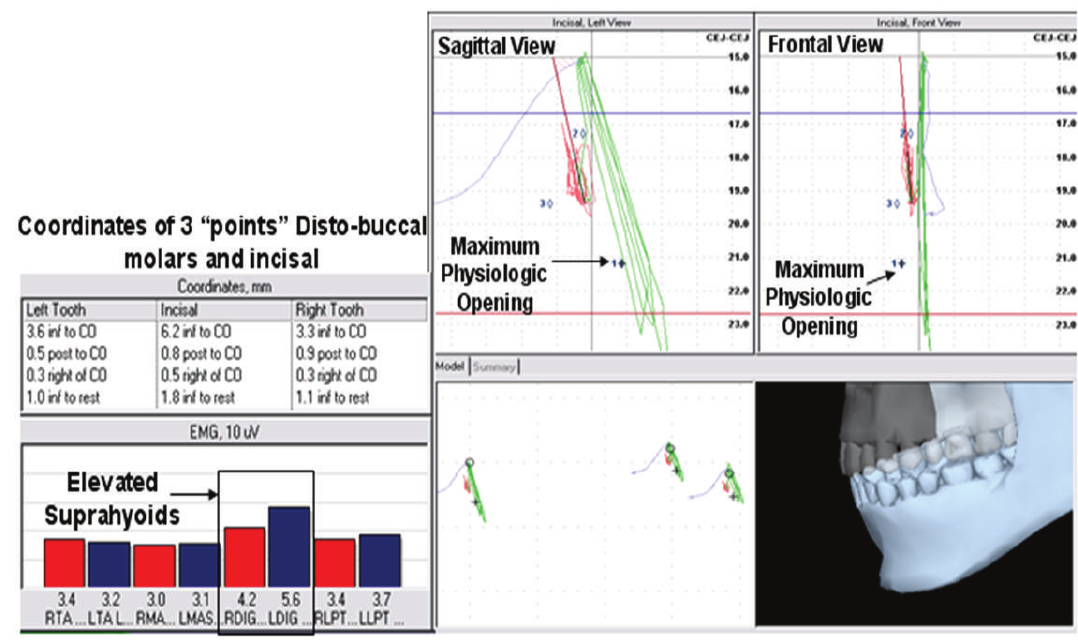
Figure 7: Spatial position of the lower jaw combined with bilateral activity of the temporalis anterior (TA), masseter (MAS), suprahyoid (DIG), and lateral pterygoid (LPT) sites. Coordinates listed are representative of mandibular position relative to centric occlusion and physiologic rest and were documented during the “burst” of suprahyoid (DIG) activity, and determined to be “Maximum Physiologic Opening”.